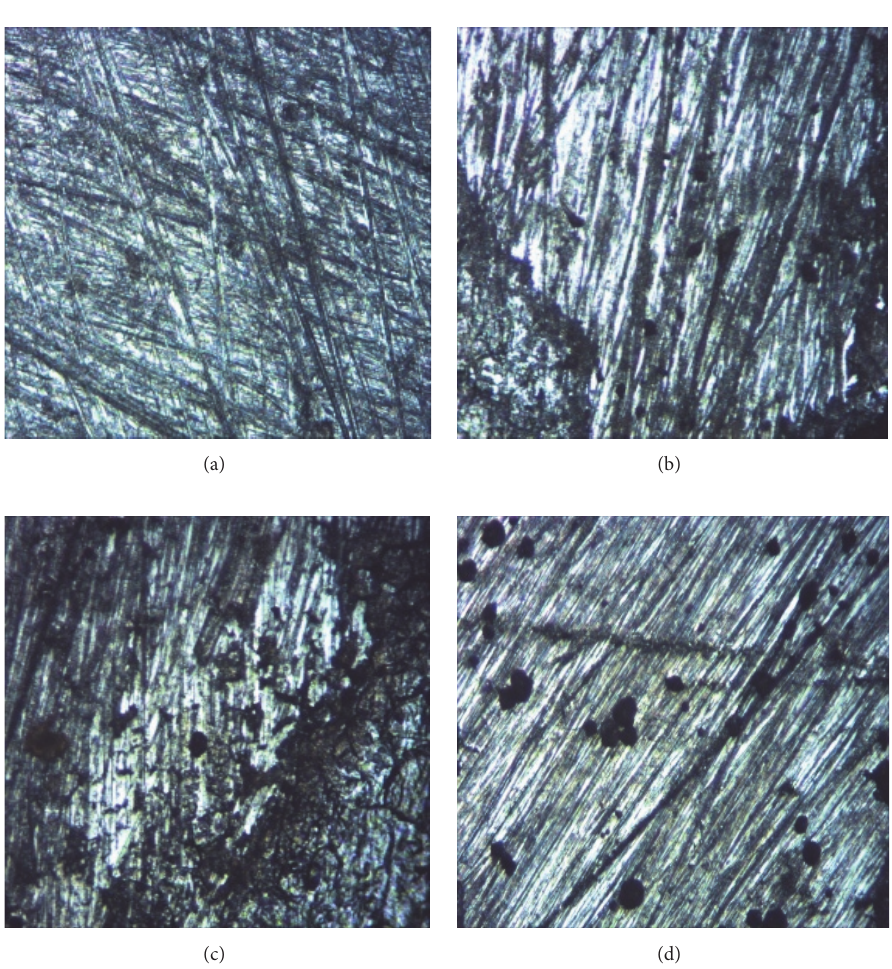
Figure 10: Microstructures of photochemically machined Inconel 718. (a) Before machining (b) at 45 ∘ C; after machining (c) at 50 ∘ C; after machining (d) at 55 ∘ C; after machining (etchant concentration: 600g/L and etching time: 40 minute).